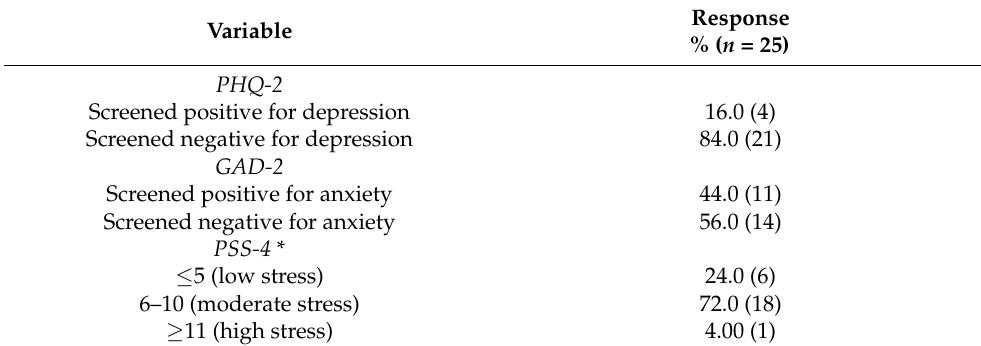
Table 2. PHQ-2 (depression), GAD-2 (anxiety), and PSS-4 (stress) screening results.